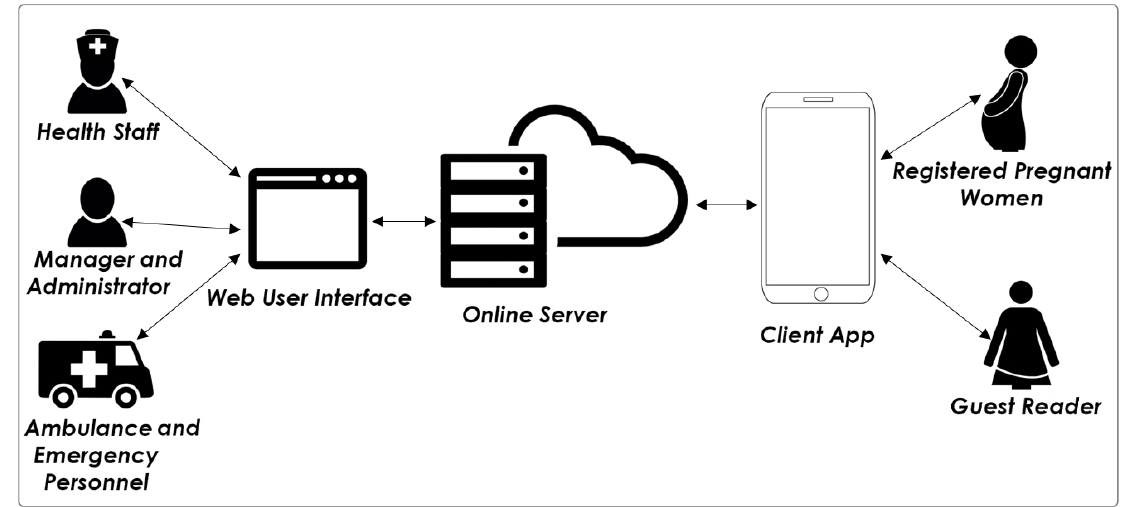
Figure 1. System architecture of the pregnancy care